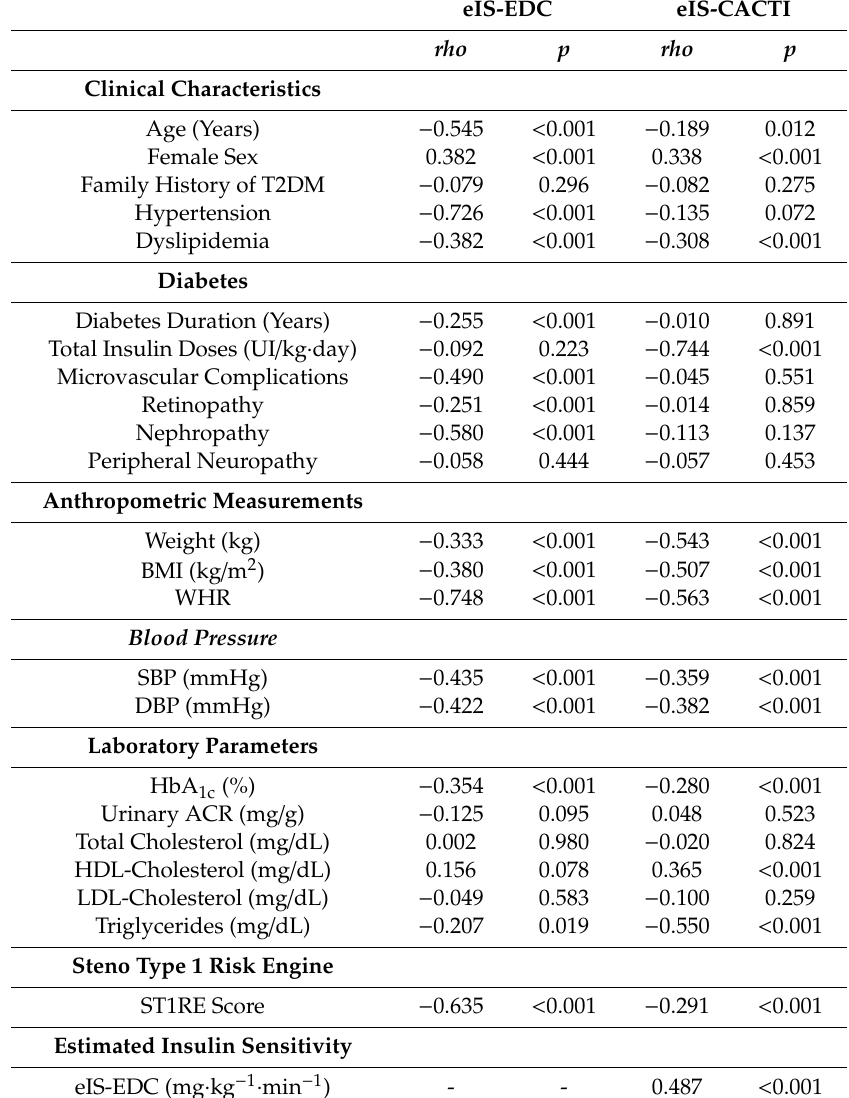
Table 2. Spearmen coe ffi cients (rho) for correlations of the two estimated insulin sensitivity equations with clinical